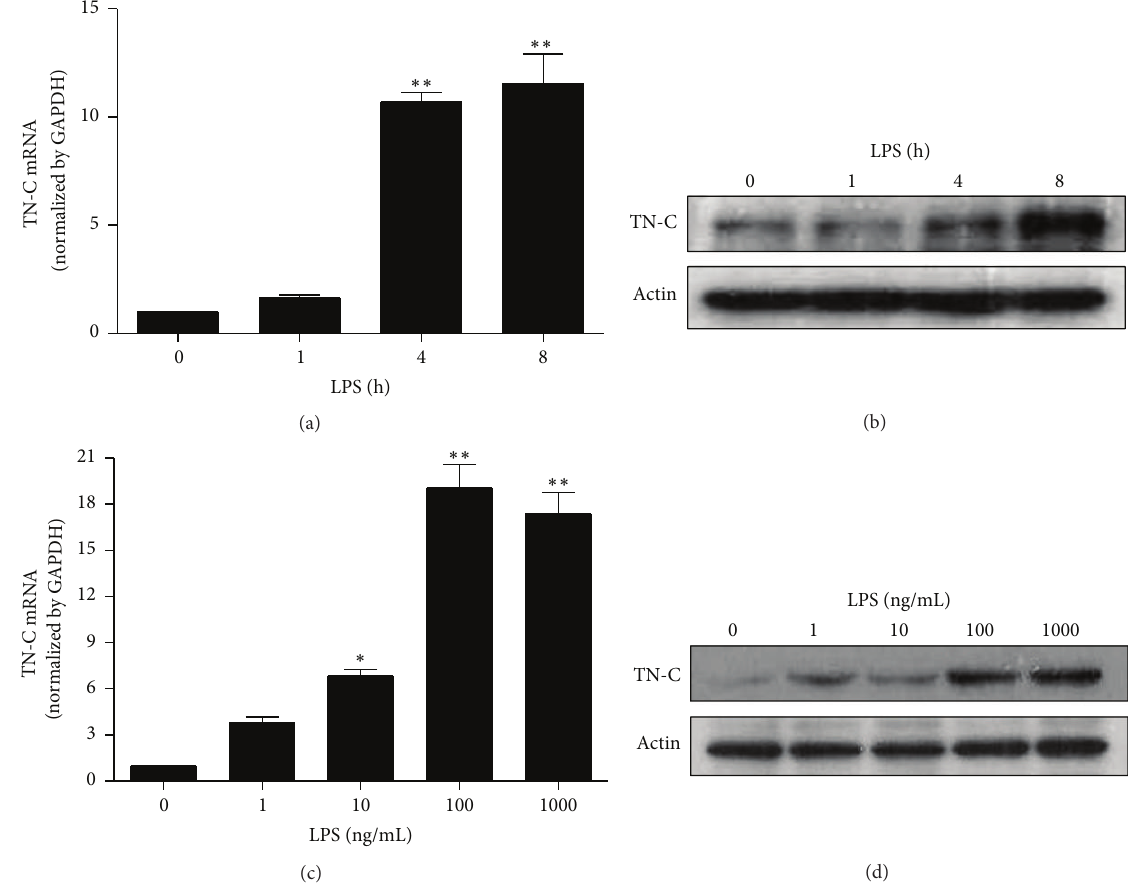
Figure 1: LPS increases TN-C expression in a time- and dose-dependent manner in RAW 264.7 macrophages. Cells were treated with 100ng/mL LPS for 0, 1, 4, and 8 h and (a) mRNA expression of TN-C was detected by Real Time RT-PCR and (b) TN-C protein expression was measured by Western blotting. Cells were treated with LPS for 8h (0, 1, 10, 100, and 1000 ng/mL). Harvested cells were subjected to (c) mRNA and (d) protein analysis for TN-C. Representative bands are shown. Data represents mean ± SEM, ∗ 𝑃 < 0.05 , and ∗∗ 𝑃 < 0.001 as compared with